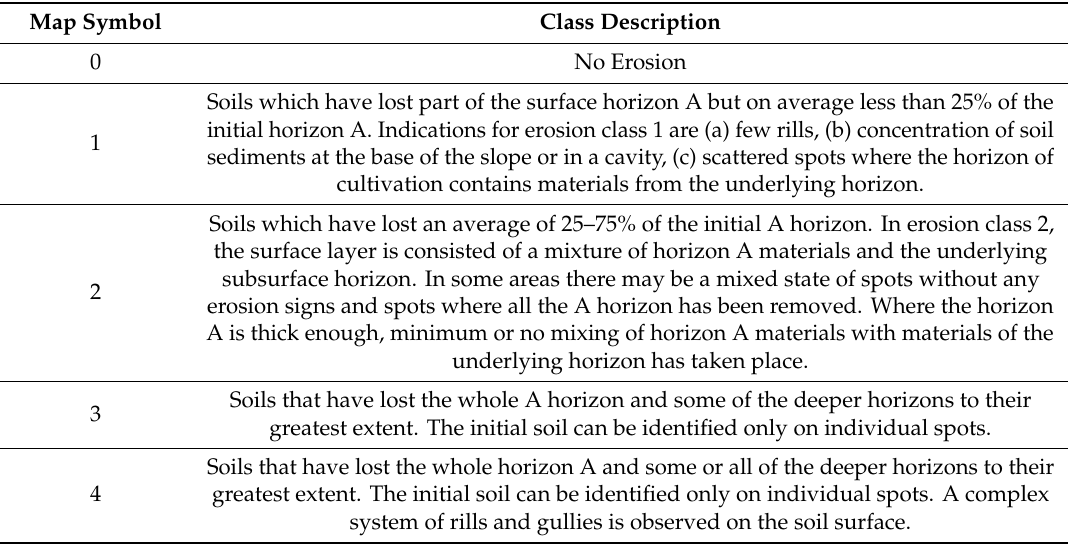
Table A4. Erosion classes and their characteristics.